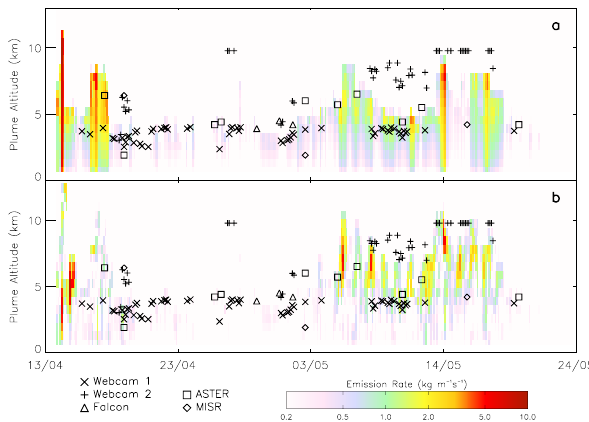
Fig. 6. Plume top heights (symbols) as a function of date, estimated from recorded images of two webcams as well as ASTER and MISR satellite data and plume observations at a distance of about 1km from the vent from the Falcon aircraft, superimposed on (a) the a priori ash emission flux and (b) the a posteriori ash emission